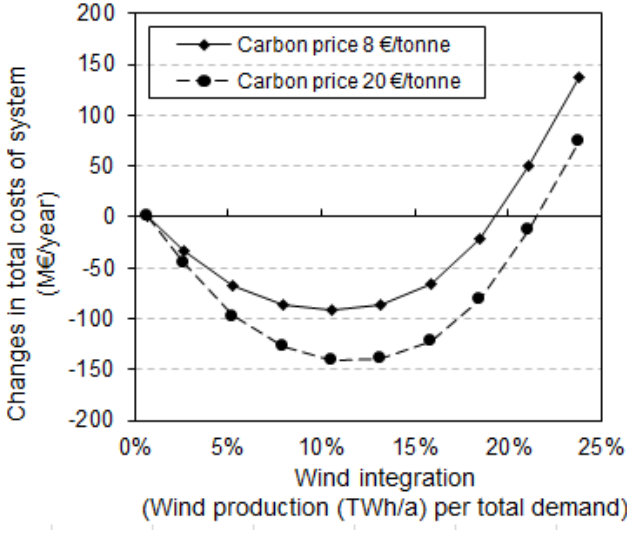
Figure 4. Changes in total costs of the energy system under different wind integration levels and emission costs compared to 2012 (interest rate 5%).